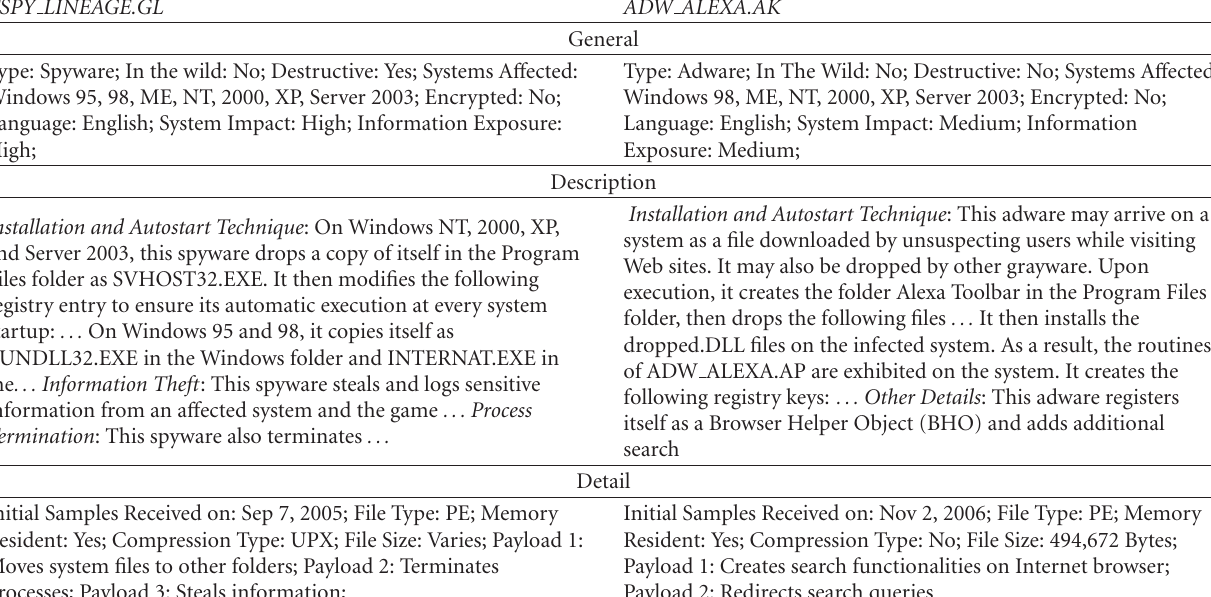
Table 1: TSPY LINEAGE.GL and ADW ALEXA.AK in Trend Micro grayware encyclopedia. TSPY